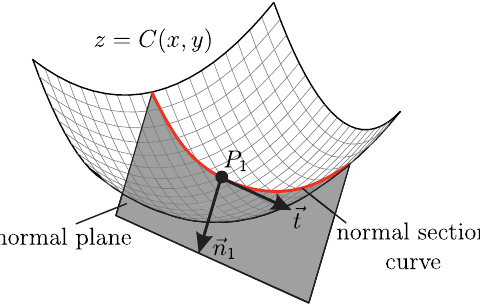
Figure A1. Normal section at P 1 of the 3D-surface C . A normal plane at P 1 , defined by the normal vector (cid:126) n 1 and any tangent vector (cid:126) t at P 1 , intersects the surface C in a so-called normal section curve. The curvature at P 1 of this curve changes for different directions of (cid:126) t . The maximum and minimum values k 1 and k 2 of this curvature are called the principal curvatures of the surface at P 1 and the corresponding tangent directions are called principal